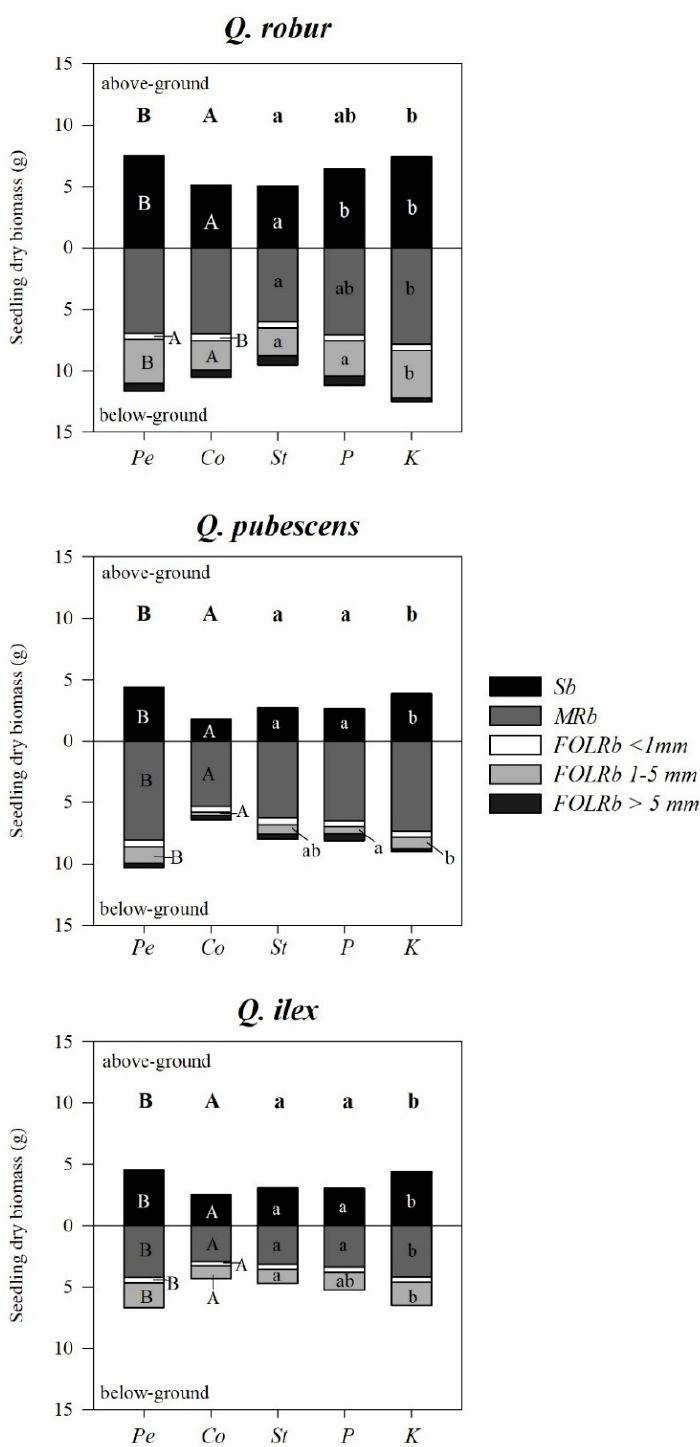
Figure 1. Multifactorial ANOVA and Tukey post-hoc test results ( p ≤ 0.05) for seedling dry biomass ( g ) allocation at the end of the growing season (N obs = 20 per stocktype per species). Source of variation—substrate ( S ), fertilization ( F ). Sb —shoot-system dry biomass; MRb —main root dry biomass; FOLRb —dry biomass of first order lateral root split by diameter class ( < 1 mm, 1–5 mm, > 5 mm). Capital letters indicate homogenous groups for substrate, while lowercase letters indicate homogenous groups for fertilization; letters in the upper part indicate groups for total biomass. Pe = Peat; Co = Coir; St = Standard fertilization; K = K-enriched fertilization; and P = P-enriched